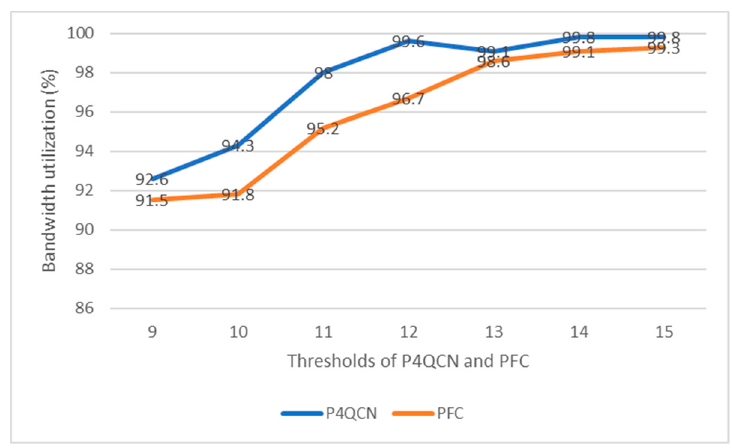
Figure 17. Bandwidth utilization comparison of P4QCN and PFC.